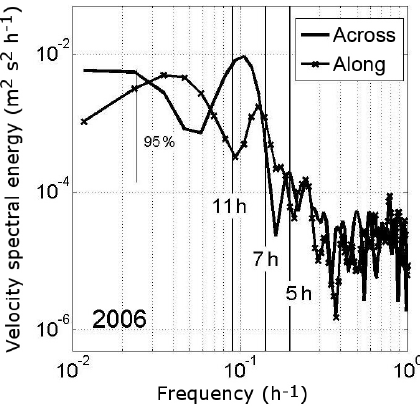
Figure 4. Spectra of bottom velocities recorded at station A2 in